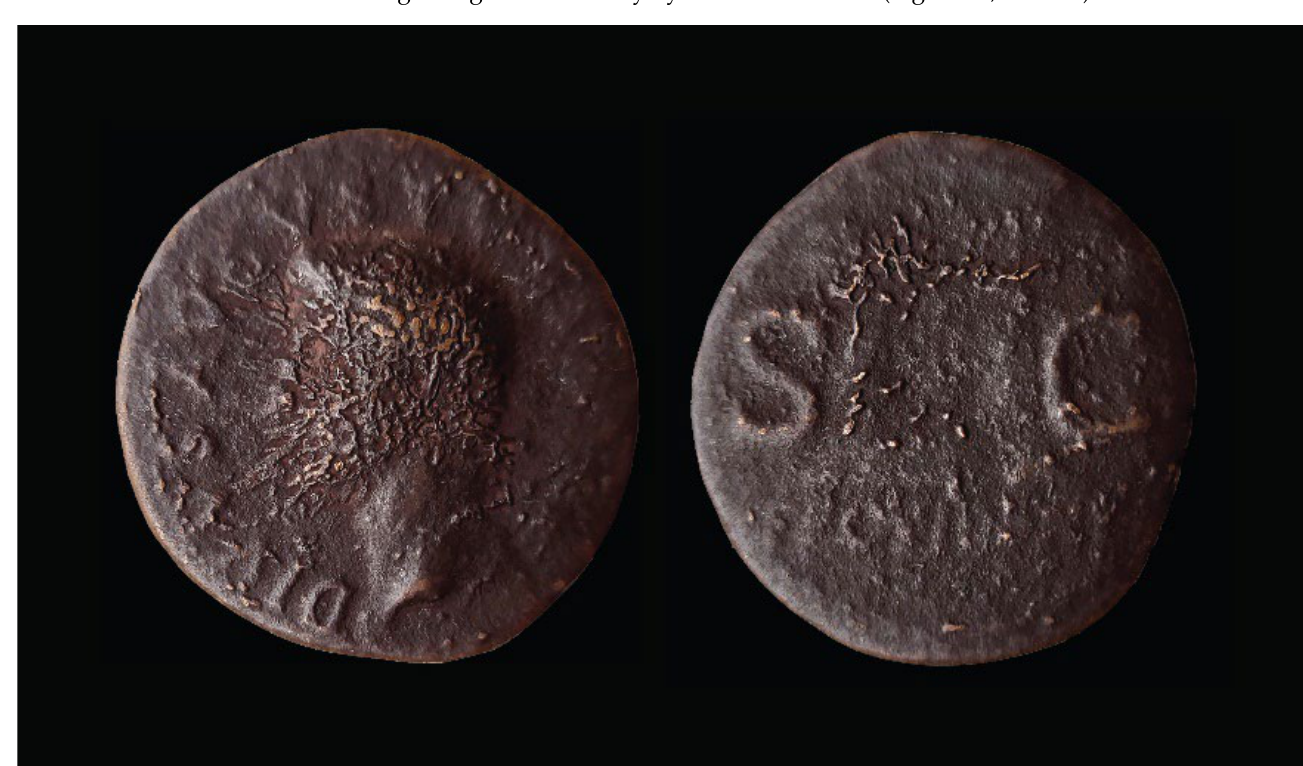
Figure 7. Bronze As of Tiberius, minted in Rome between 22 AD and 30 AD, found next to the road Aquileia–Tarsatica in the village of Basovizza. Private collection.